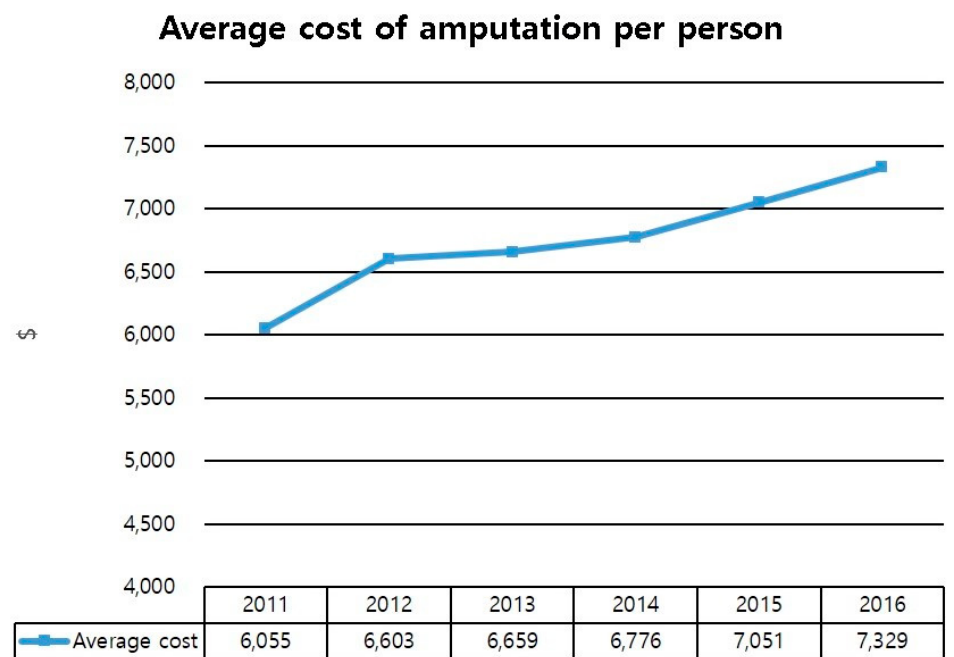
Figure 4. The average cost of amputation, per person, of diabetic foot ulcer with PAD.